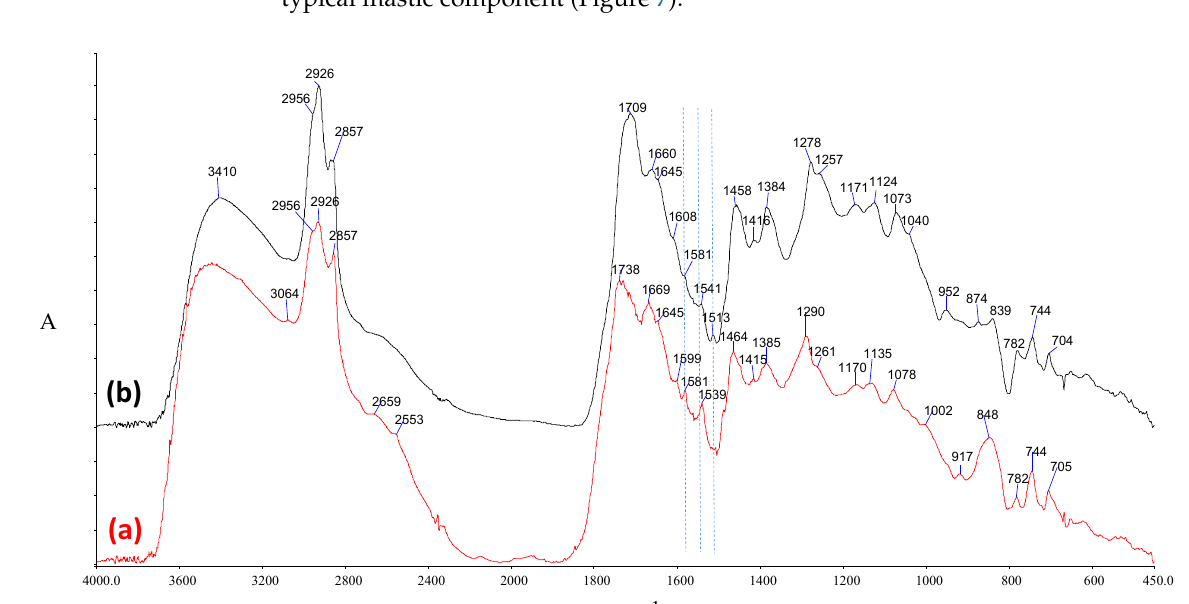
Figure 6. Infrared spectra of varnish powder samples; ( a ) D13 and ( b ) D16. Dashed vertical lines depict correspondence of aromatic and metal salt features between the two samples.